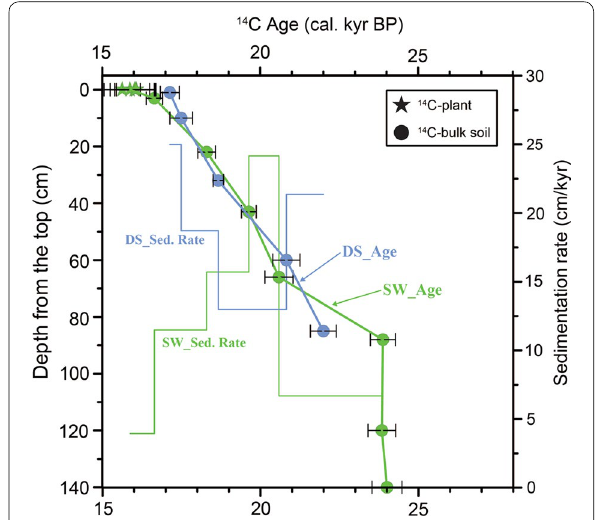
Fig. 2 Age‑depth models and associated sedimentation rates in two sites of the Gosan Formation sediments (blue, site GSDS; green, site GSSW), on the basis of AMS radiocarbon ( 14 C) dates (Lee et al. 2014b; Lim et al. 2015). The 14 C dates (with the 2 σ error bars) indicated as the tie‑points with circle and star symbols were measured on organic materials extracted from bulk soils, and on plant remains, respectively, and were calibrated using the OxCal program (http://c14.arch.ox.ac. uk/embed.php?File oxcal.html). Note that the sedimentation rates at = the 88–140 cm interval in the site GSSW were not